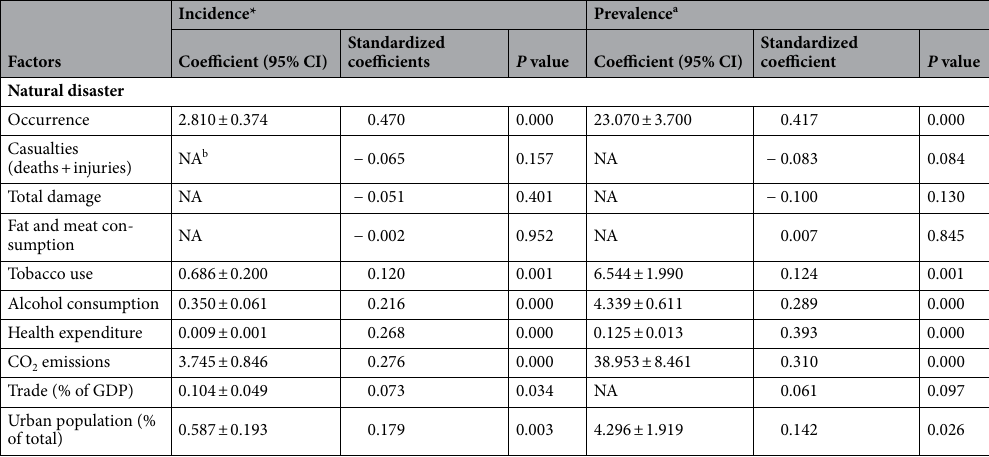
Table 2. Multivariable linear regression-derived coefficients for natural disaster and socioeconomic variables for the incidence and prevalence of ischemic stroke in females from 1990 to 2017 in 193 countries, weighted by population. *The stepwise method was used, R 2 = 0.799, F = 103.811, p = 0.000. a The stepwise method was used, R 2 = 0.764, F = 99.377, p = 0.000. b Not applicable for variables not included as